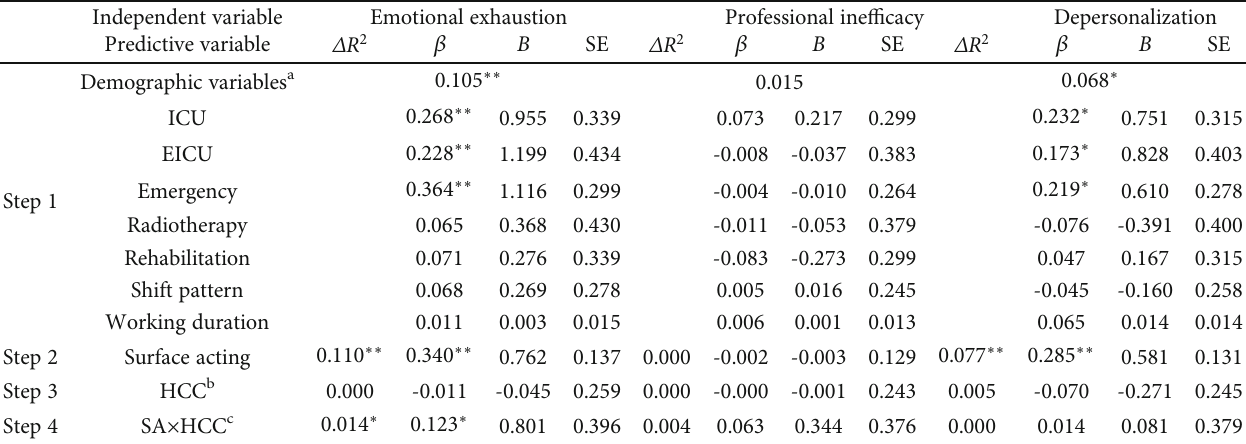
Table 2: Coe ffi cients of multiple linear regression of surface acting, hair cortisol content, and their interaction against Maslach job burnout ( n = 229 ).